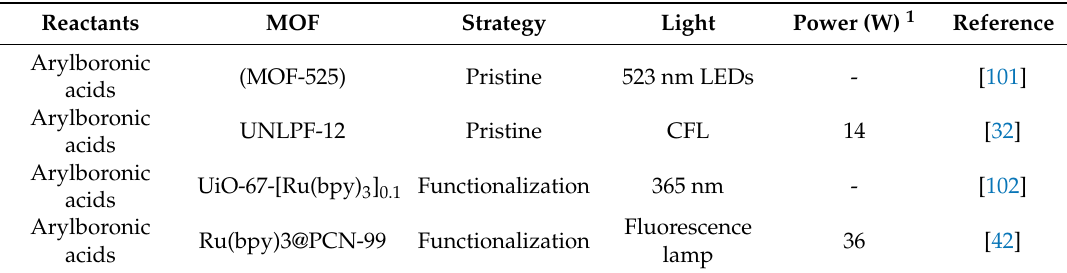
Scheme 6. Mechanism of the photooxidation of arylboronic acids. Table 7. Photooxidation reactions of arylboronic acids mediated by